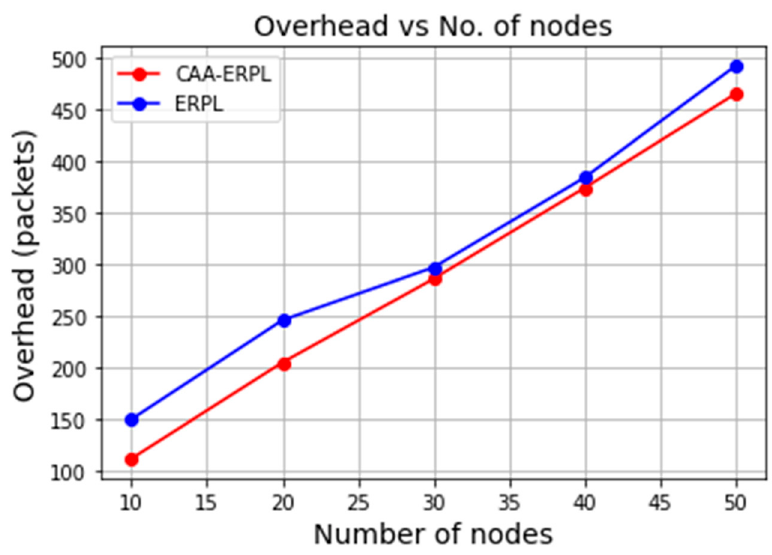
Figure 6. Overhead vs. number of